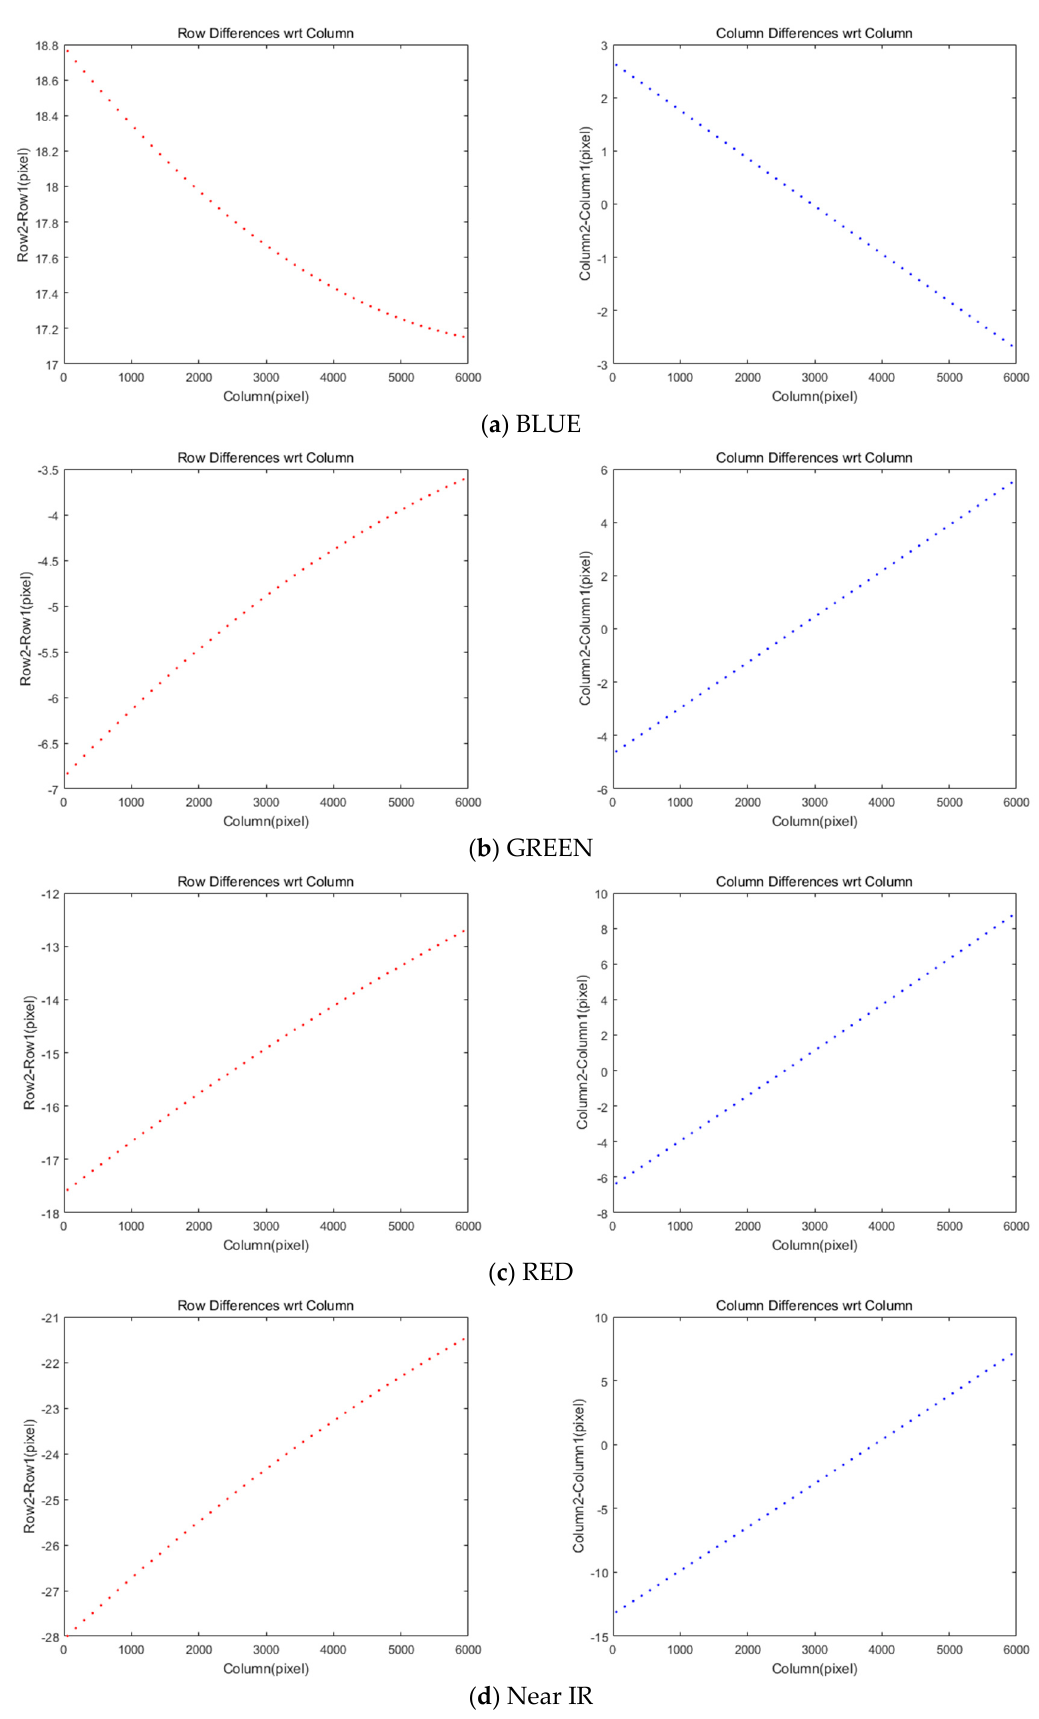
Figure 5. Differences of rows and columns in coordinates between MS and PAN images. Figure 5. Di ff erences of rows and columns in coordinates between MS and PAN